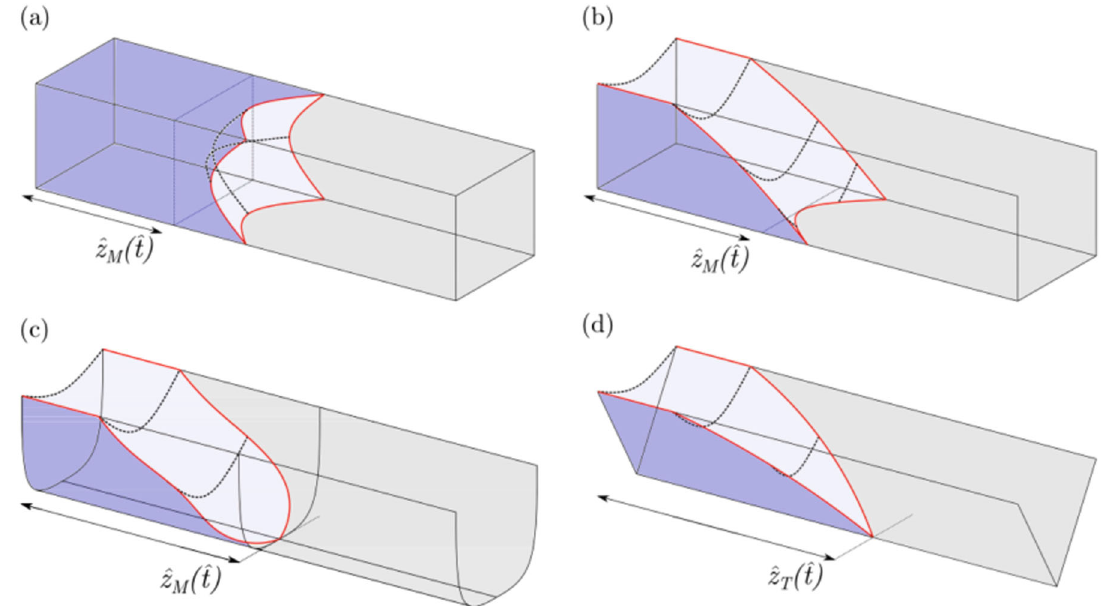
Fig. 1 Microchannel shapes. Schematic of fl ow in ( a ) closed rectangular, ( b ) open rectangular, ( c ) open U-shaped, and ( d ) open V-shaped